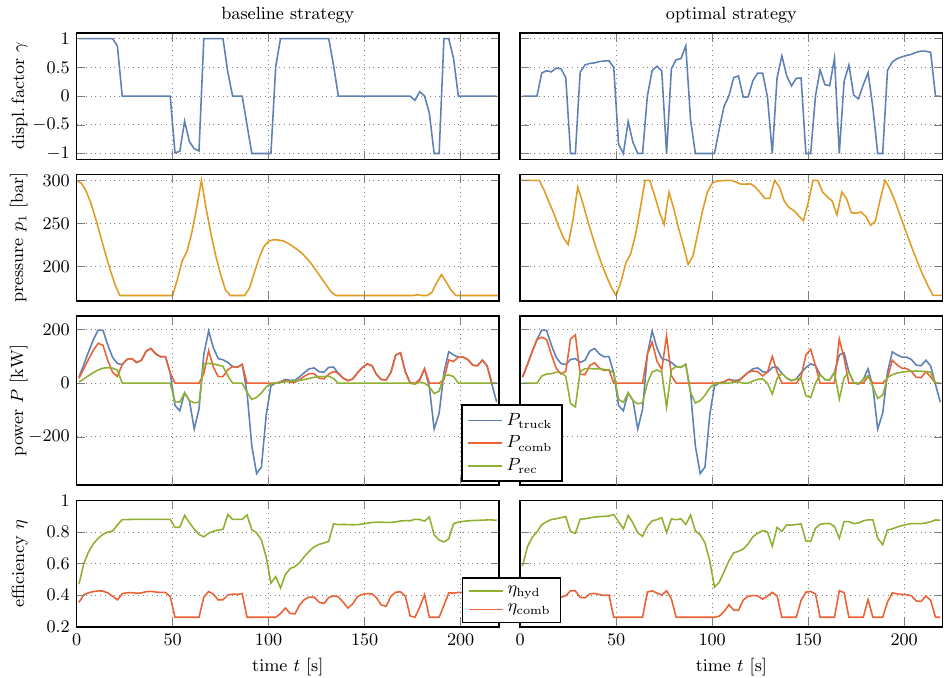
Figure 7. From top to bottom: displacement factor, gas pressure, power and efficiencies of hydraulic unit and combustion engine over time for ( left ) baseline strategy and ( right ) optimal strategy. The resultant diesel fuel savings using the baseline strategy are 19.1%. Having the baseline strategy as a reference we can now look at the optimized control